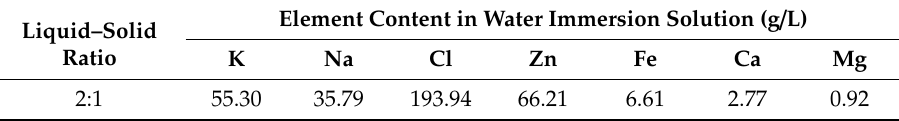
Table 2. Element concentration of RHF secondary dust water immersion.